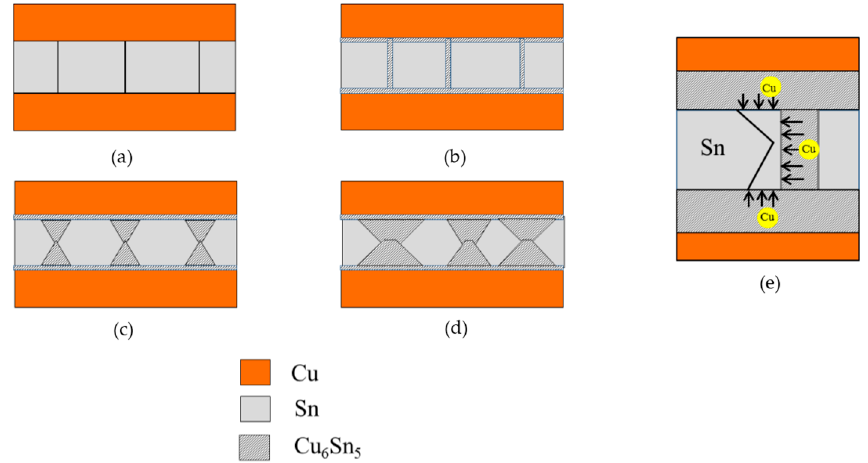
Figure 7. ( a – d ) Schematic diagram of Cu 6 Sn 5 IMC formation in the Cu/Sn system during room temperature aging and ( e ) diffusion of Cu atoms into Sn to form Cu 6 Sn 5 IMC.